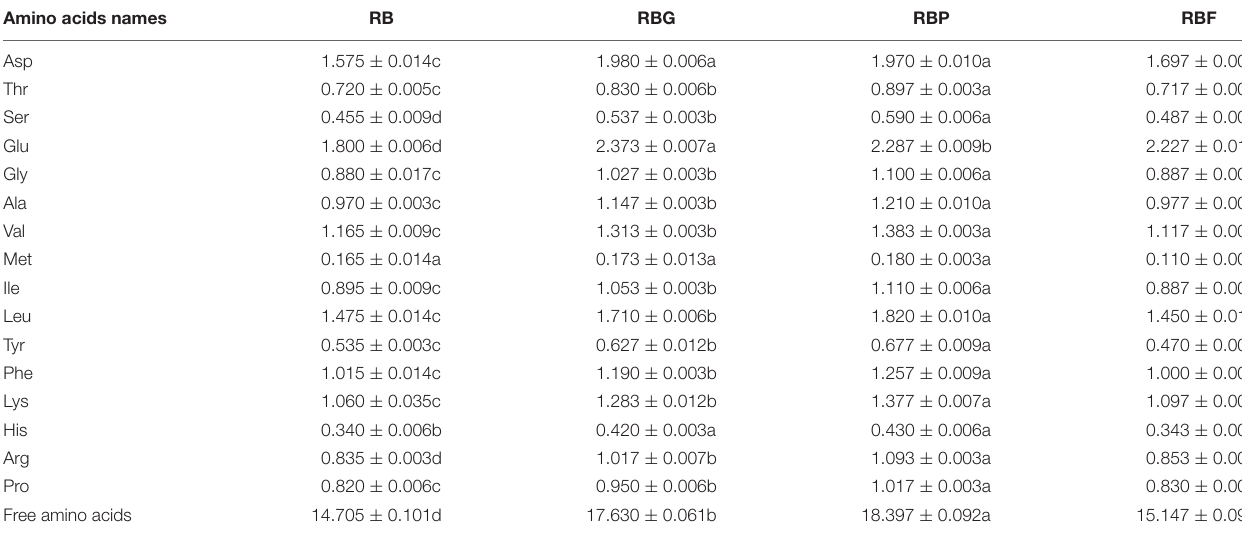
TABLE 2 | Effects of spectra on content (mg/g DW) of free amino acids in lettuce leaves. Amino acids